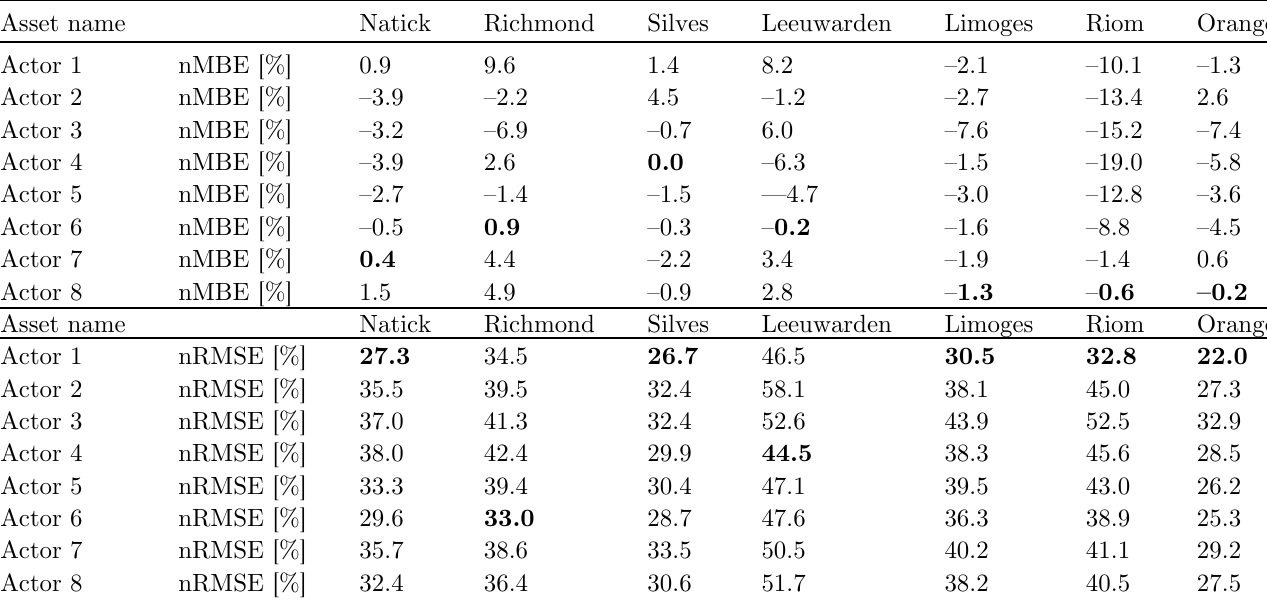
Fig. 5. nRMSE & nMAE as a function of forecast horizon for all participants averaged over all assets. Table 4. nMBE & nRMSE for each actor, each site and a time horizon of 1 hour. Best results per column are in